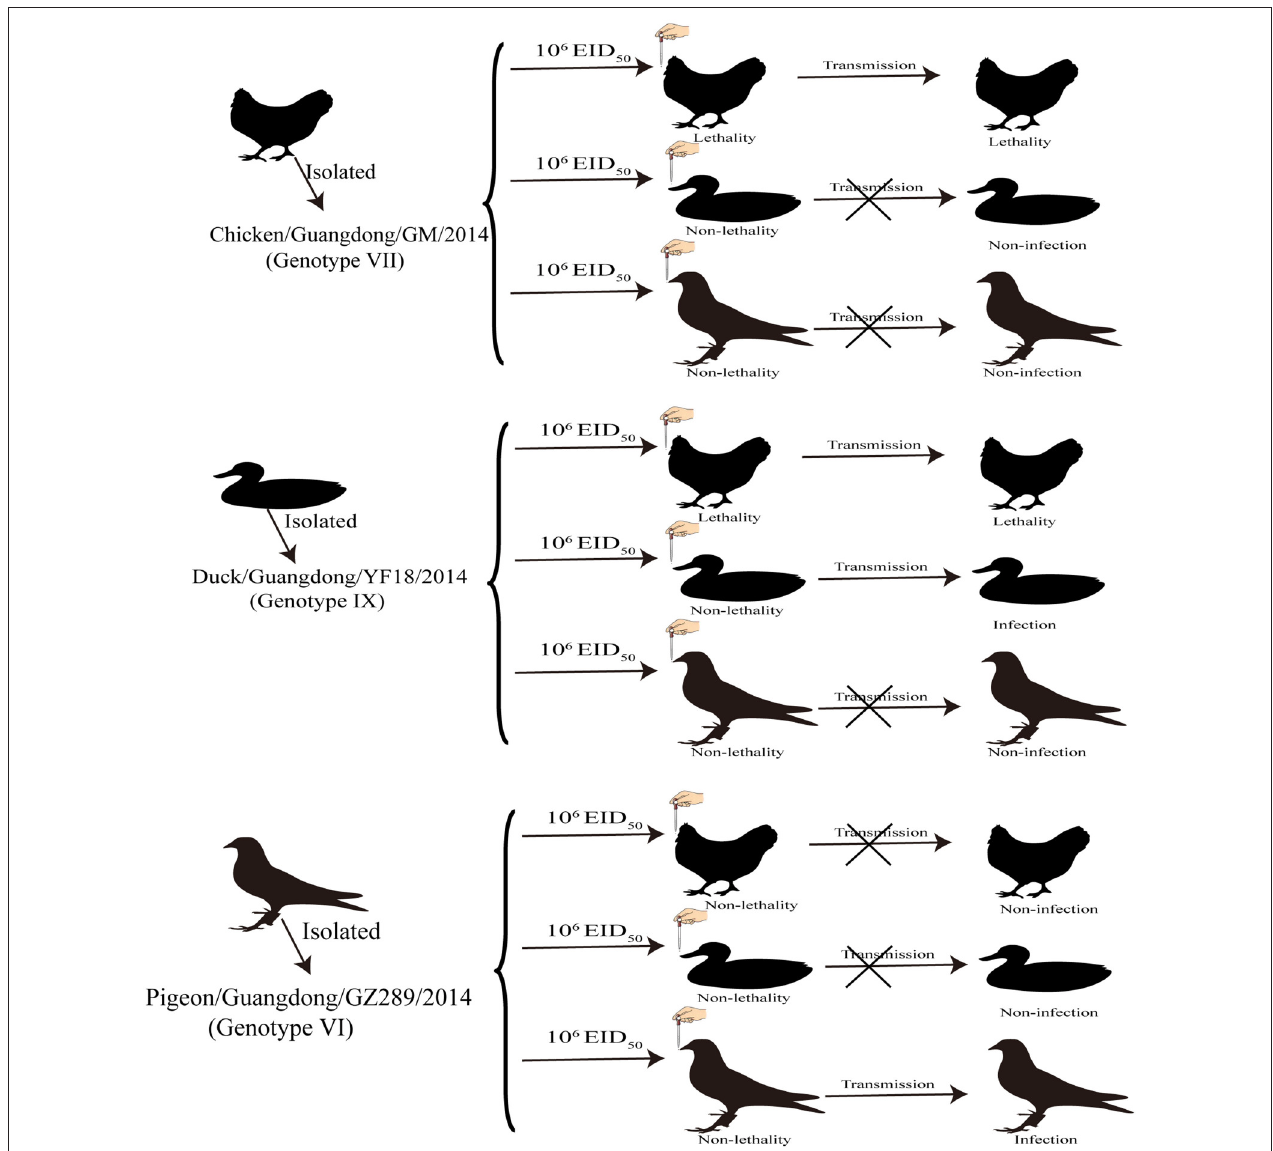
FIGURE 2 | Transmission studies of NDV in chickens, ducks and pigeons. Three groups of chickens, ducks, and pigeons were inoculated with 10 6 EID 50 of the indicated virus via the intraocular and intranasal routes and, 8h after infection, three birds were placed into the same cage to monitor contact